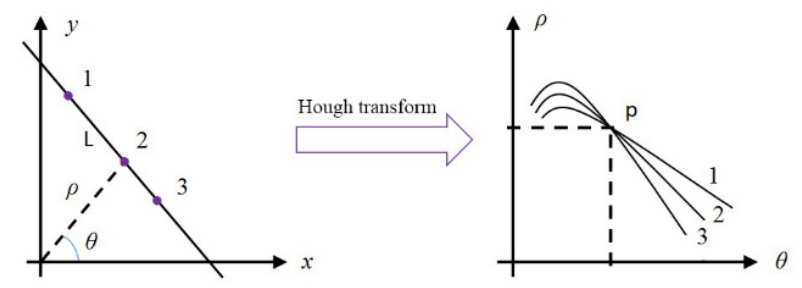
Figure 10. Hough transform schematic.